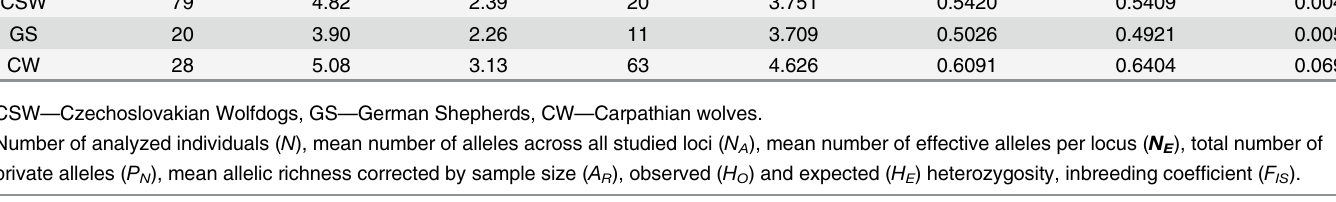
Table 2. Genetic variability in the three analyzed groups at 39 autosomal microsatellite loci. Group N N A N E F IS CSW CW